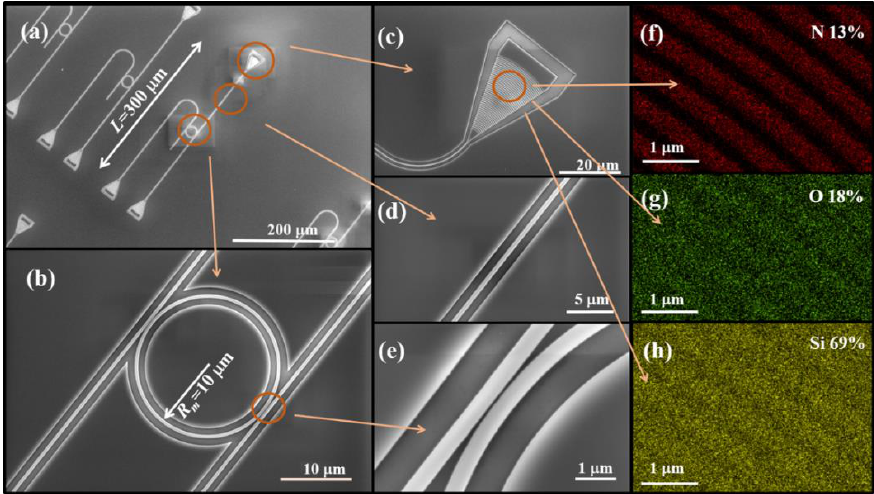
Figure 3. ( a – e ) The SEM images of the fabricated Si 3 N 4 waveguide structure. ( f – h ) The EDS images of the fabricated Si 3 N 4 waveguide structure .